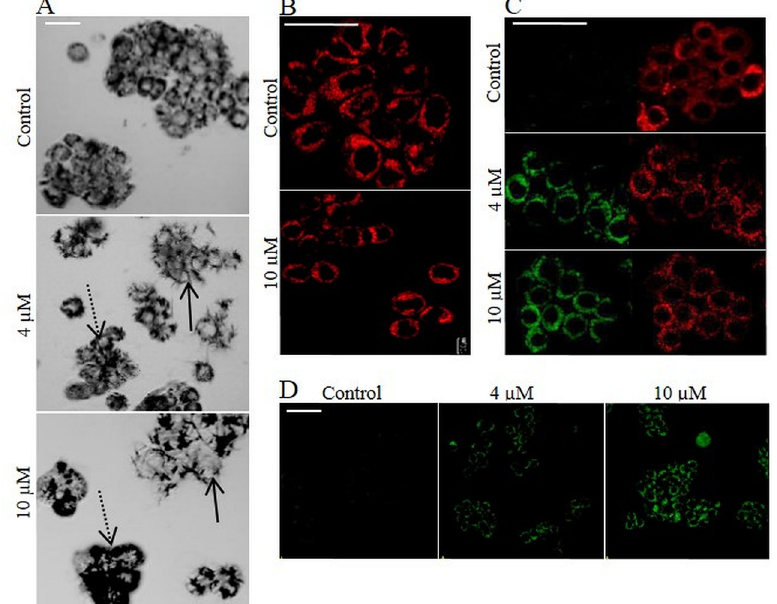
Fig 6. Effect of 2-oxoheptyl ITC on MTT reduction. (A) Microscopic images of formazan crystals. HT-29 cells were incubated with 4 and 10 μ M 2-oxoheptyl ITC for 24 h. Microscope images were recorded after 3 h of reduction of MTT. Black dots indicate formazan crystals (dashed line arrow). Needle-shaped formazan crystals larger than the cells are denoted with solid line arrows. (B) Mitochondria of HT-29 cells after 24 h incubation with 2-oxoheptyl ITC. Cells were stained with MitoTracker 1 Deep Red. (C) HT-29 cells were incubated with 4 and 10 μ M 2-oxoheptyl ITC and stained with MitoLight dye, which stains mitochondria in a membrane potential-dependent fashion. Changes in the mitochondrial membrane potential ΔΨ m were detected by confocal microscopy. Left image presents the detection of the monomers (green fluorescence), indicating the presence of depolarized mitochondria. Right image presents the fluorescence of the aggregates (red fluorescence), indicating functional, polarized mitochondria. (D) Microscope images of the intracellular reactive oxygen species induction (ROS) by 2-oxoheptyl ITC (green fluorescence). HT-29 cells were incubated with 4 and 10 μ M 2-oxoheptyl ITC for 24 and stained with the ROS-sensitive dye DHR123. Scale bar = 50 μ